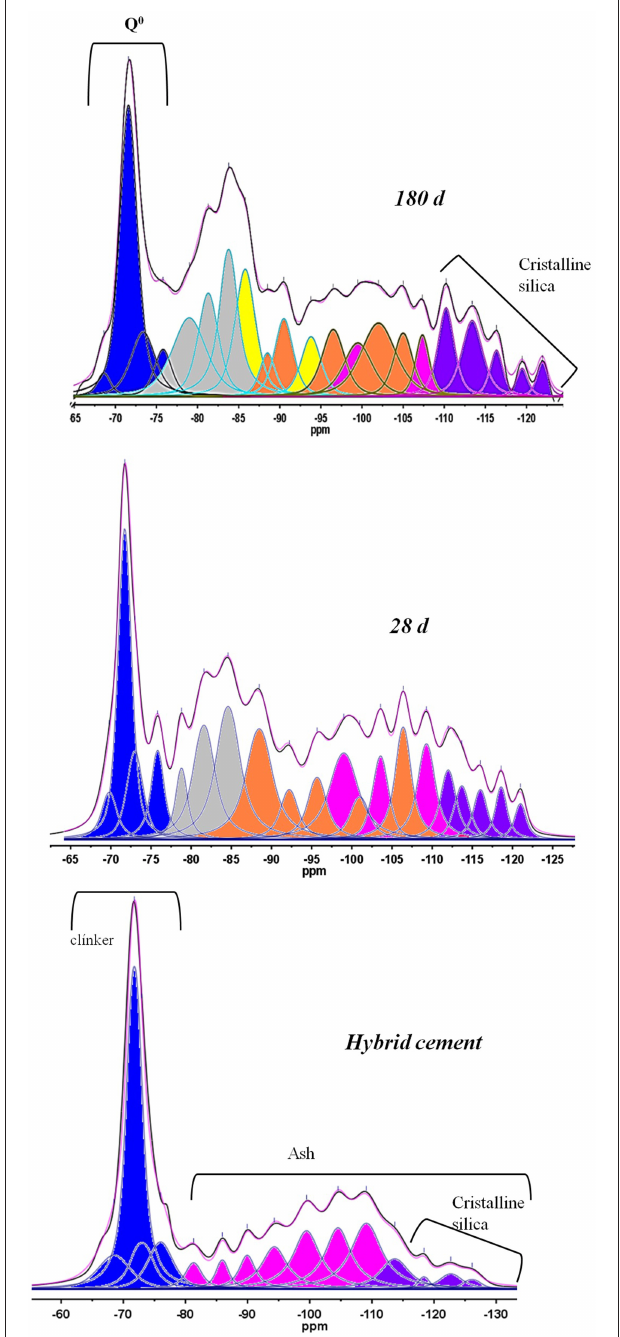
FIGURE 4 | 29 Si MAS NMR spectra for anhydrous and 28 d and 180 d hydrate hybrid belitic cement. Legend for hydration products: gray (Q 1 , Q 2 (0Al)(1Al)); orange (Q 4 (0Al)(1Al)(2Al)(3Al)(4Al)); yellow (Q 3 (1Al)(3Al)).